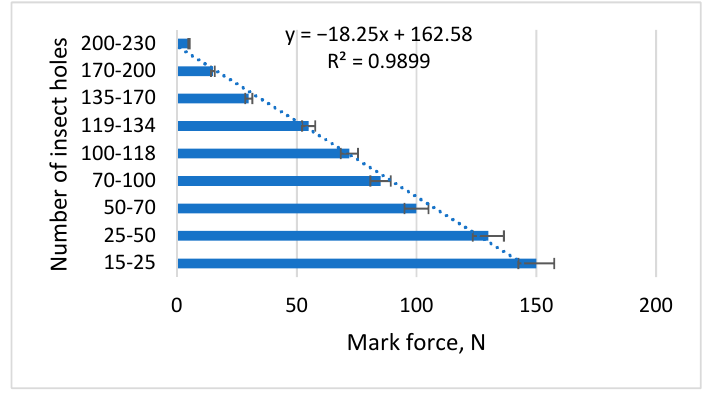
Figure 13. Influence of the number of holes on the Mark force stiffness.